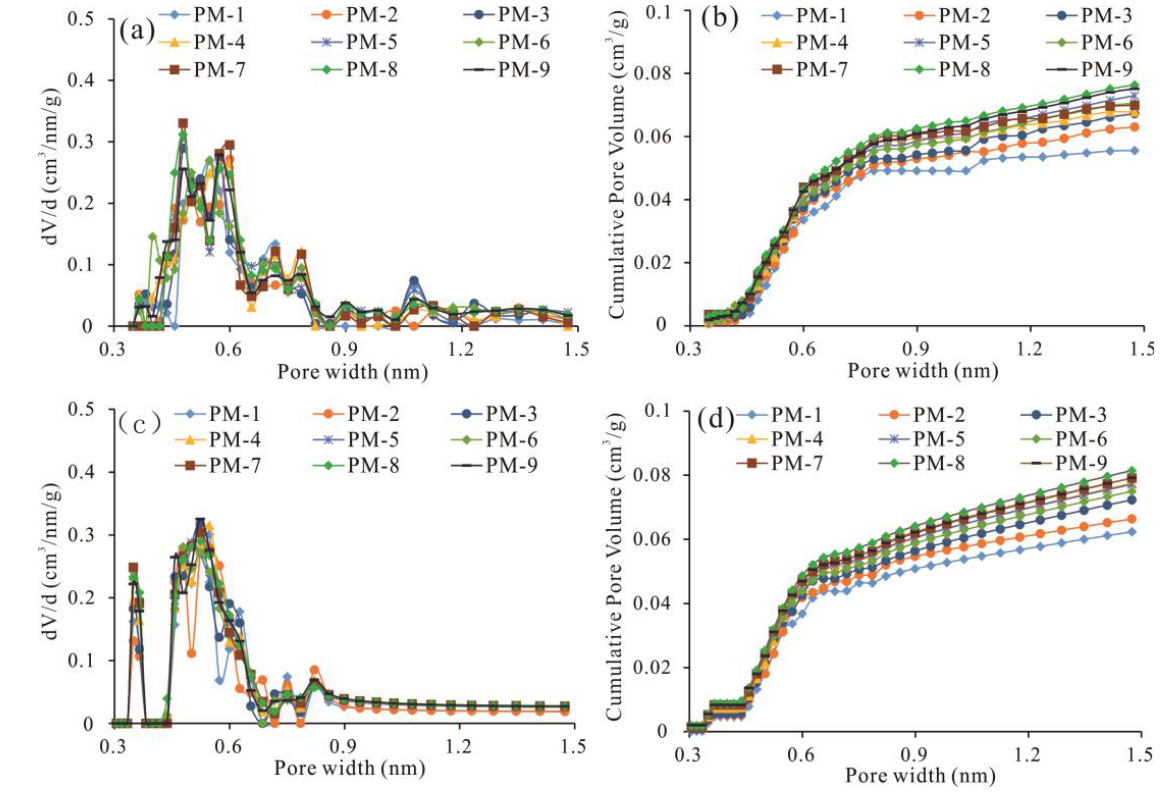
Figure 4. Distribution of the PV calculated by different models for different pores sizes. ( a , b ) GCMC model, ( c , d ) NLDFT model.